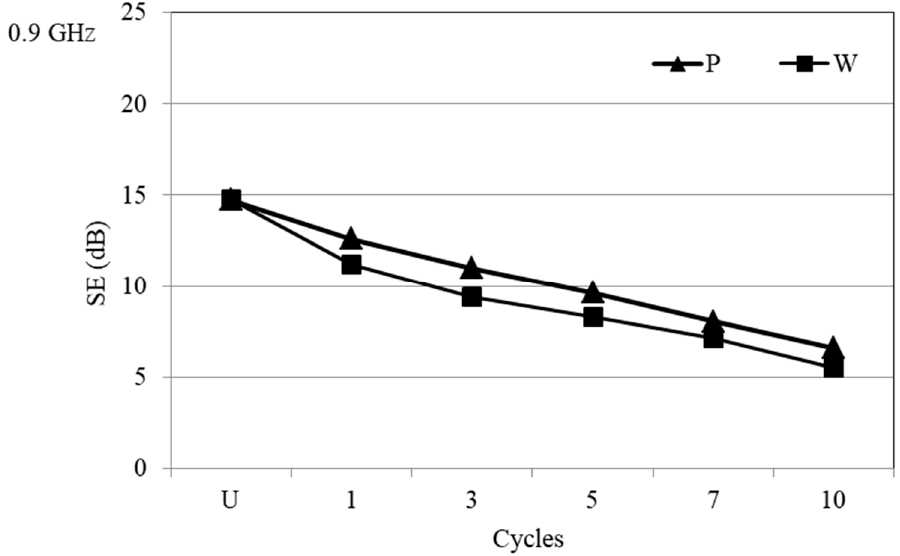
Figure 7. SE of the PA/Ag fabric before and after 10 cycles of treatment with P and W at the frequency of 0.9 GHz.